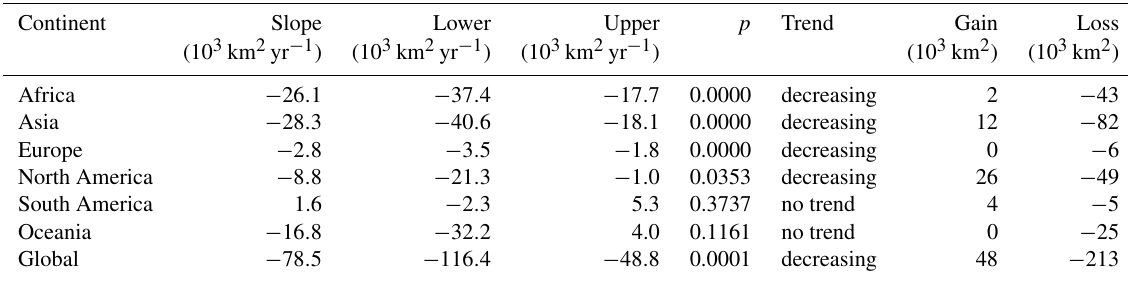
Table 12. Statistical results of change analysis for barren land (on the scale of continents). Annual change slope and its 95% confidence interval are given by Theil–Sen estimator, p value, and trend information from a Mann–Kendall test. Gain and loss areas are summarized results relating to the whole time